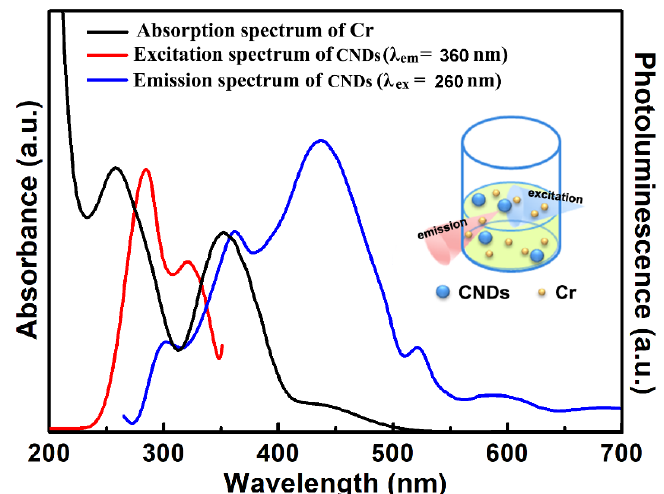
Figure 7. Absorption spectrum of the Cr(VI) (black curve), PL spectrum of the CNDs (blue curve, excited by 260 nm) and PLE spectrum of the CNDs (red curve, recorded at 360 nm emission). Inset: Scheme of the light absorption in the CNDs-Cr(VI) sensing system.